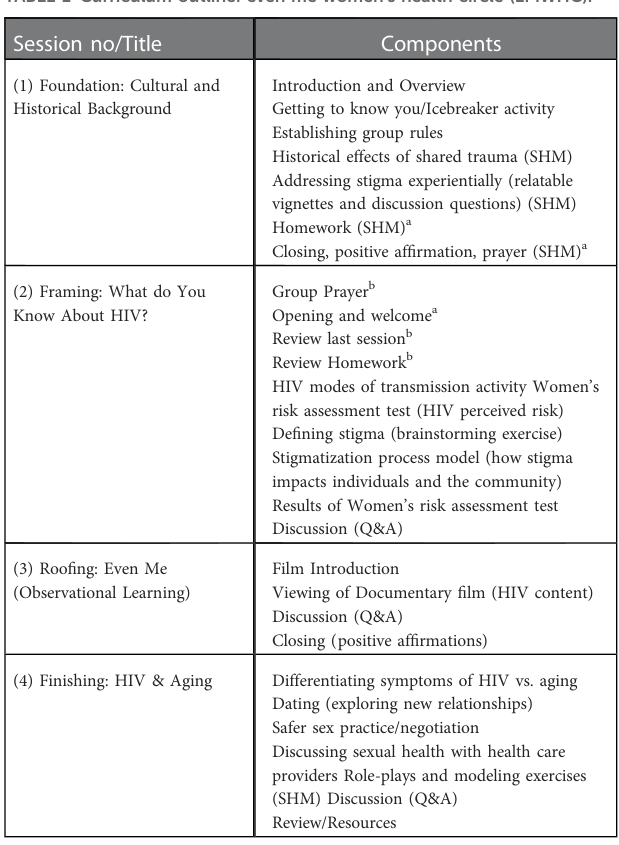
TABLE 1 Curriculum outline: even me women ’ s health circle